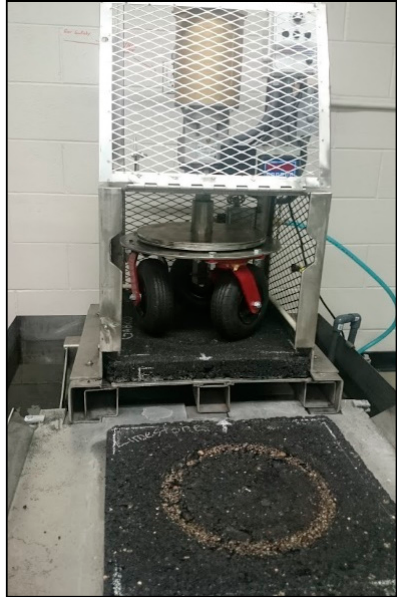
Figure 5. ( a ) Dynamic friction tester (DFT) device; ( b ) Bottom of the DFT with three rubber sliders.